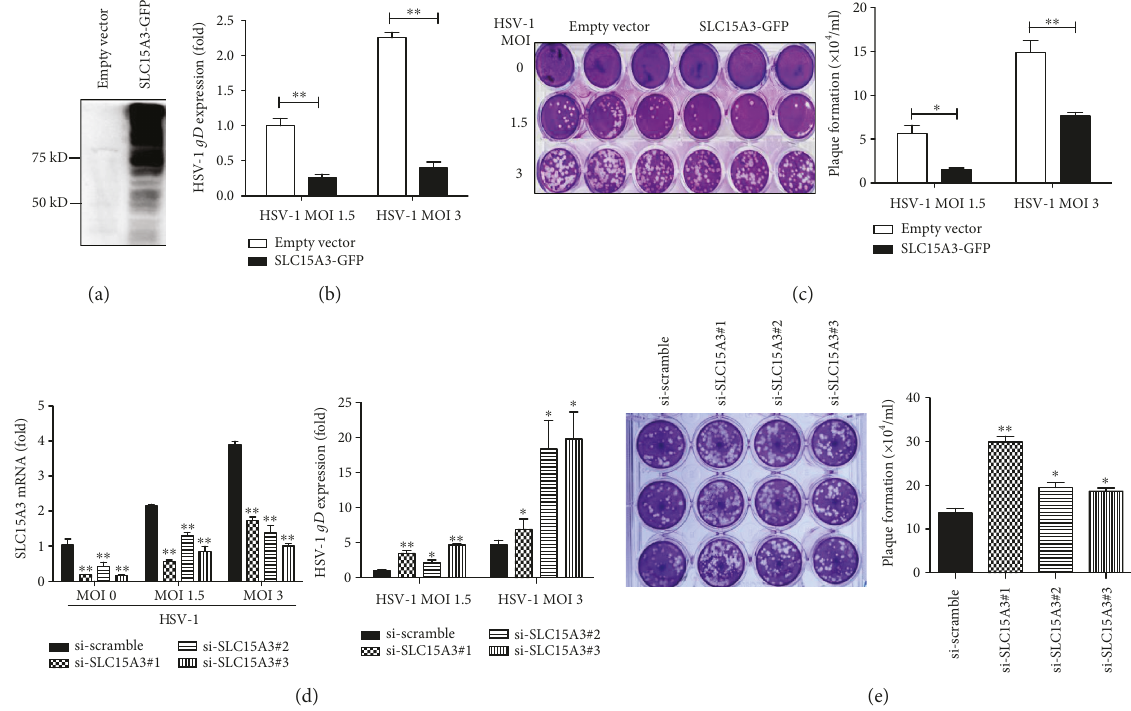
Figure 3: SLC15A3 protects host cells from HSV-1 infection. (a) Western blot analysis of SLC15A3 protein in 293T after overexpression. (b) PCR analysis of HSV-1 gD gene abundance in SLC15A3 overexpressed 293T cells. (c) Plaque assays of HSV-1 infectious particles produced in